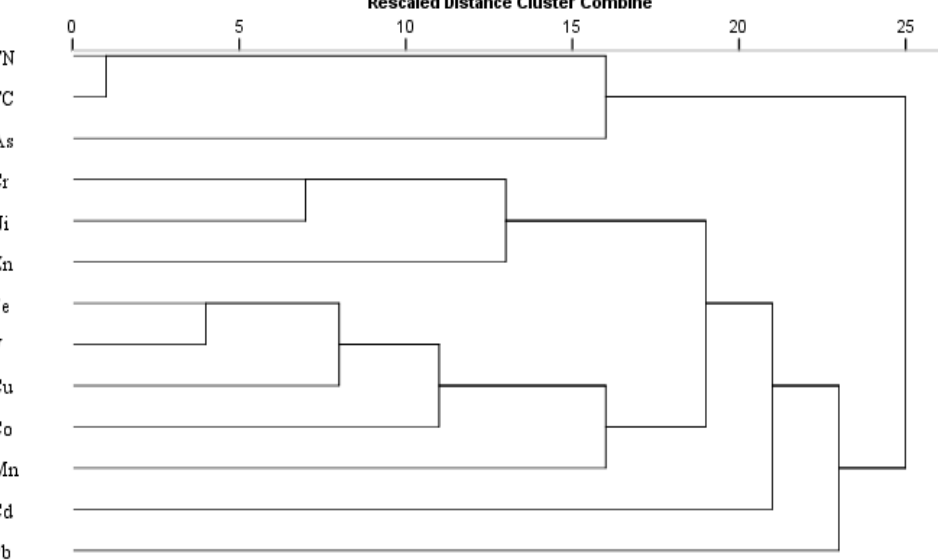
Figure 3. Dendrogram using average linkage. Figure 3.